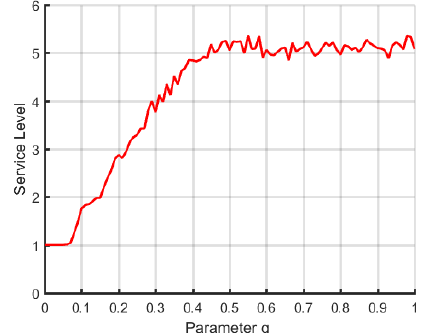
Figure 1. The changing trend of the average value of the service level estimated with the increasing of the q